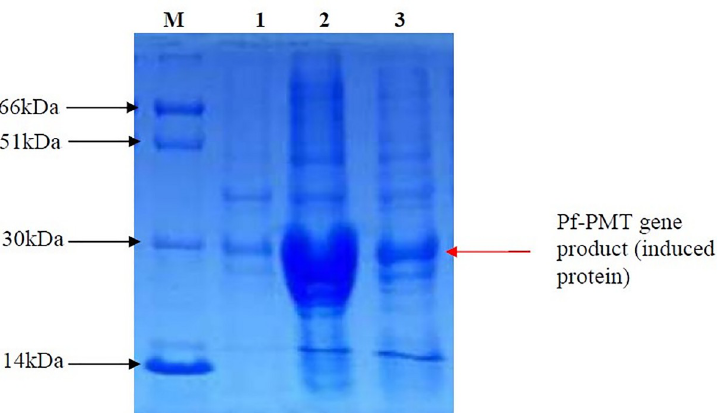
Fig 9. Protein Expression Checking (Pf- PMT ) , Loaded on12%SDS-PAGE. (1)–Before induction sample (whole cell extract). (2)– 16 hours after induction sample (whole cell extract). (3)– 4 hours after induction sample (whole cell extract), M–Protein